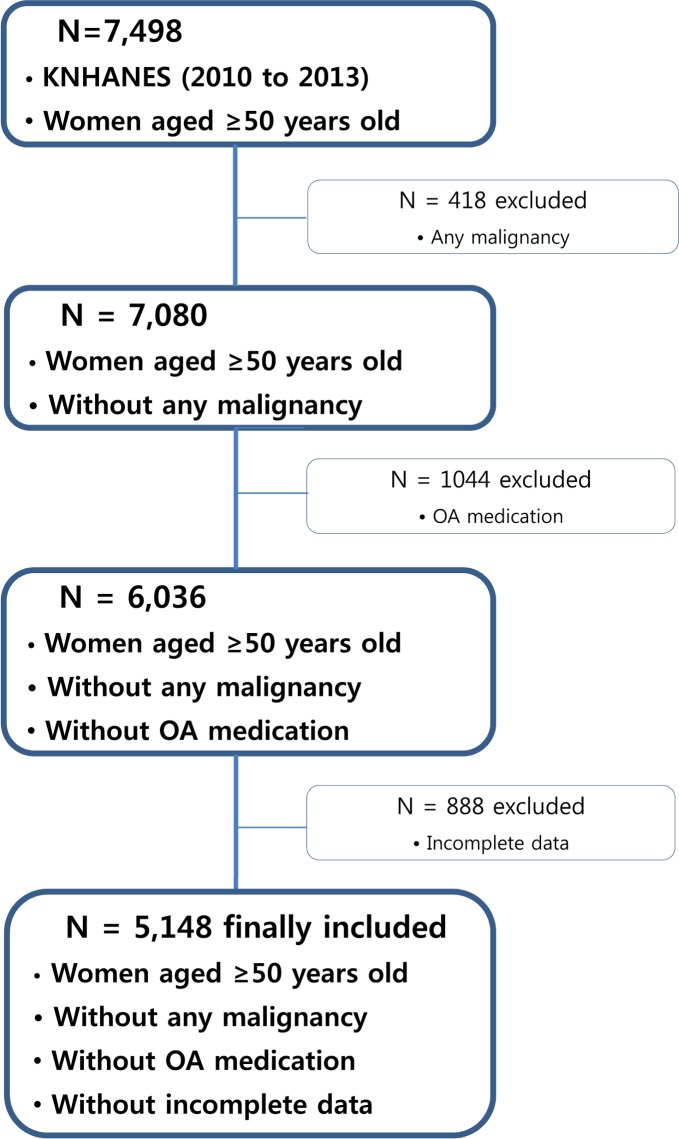
Flow diagram of the inclusion and exclusion criteria for the Korea National Health and Nutrition Examination Survey (KNHNES).A total of 5148 women aged 50 years or older were included.